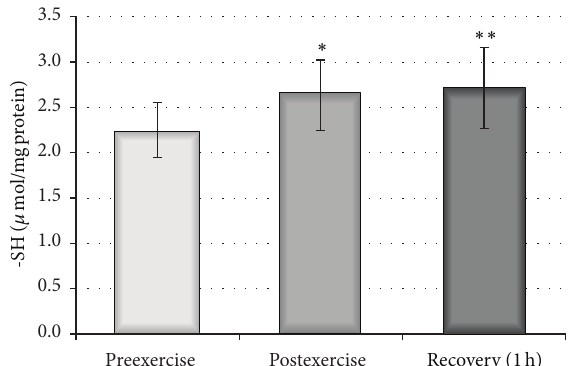
Figure 7: Effect of physical exercise on thiol group concentration in plasma measured before, after, and 1 hour after physical exercise. ∗ indicatessignificantdifferencebetweenpreexerciseandpostexercise ( 𝑃 < 0.02 ); ∗∗ preexercise and 1 hour recovery ( 𝑃 < 0.01